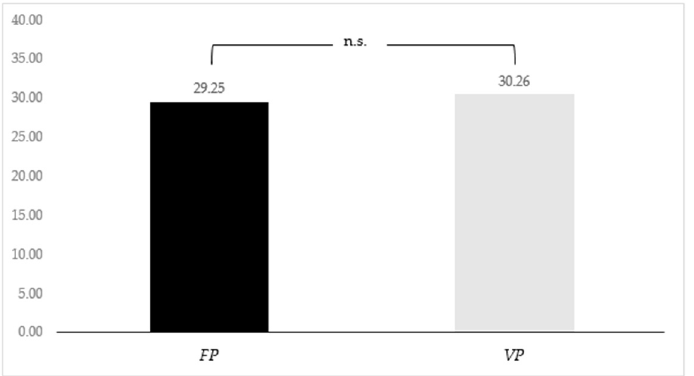
Figure 1. Average effort choices in 𝐹𝑃 vs. 𝑉𝑃 .